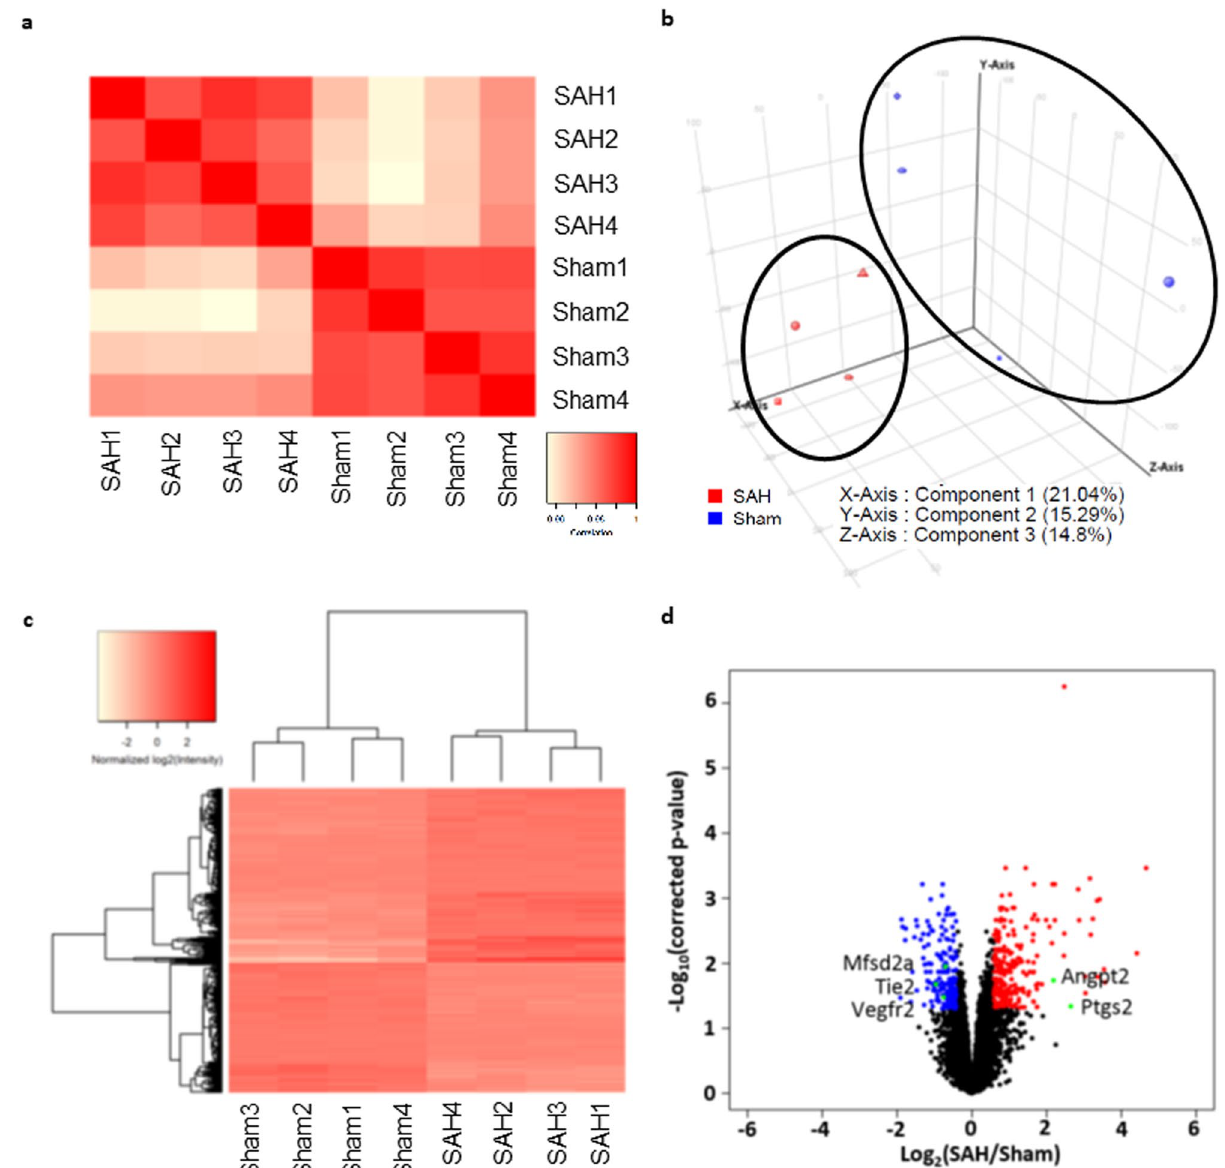
Figure 4. Gene expression profiling of CD45–CD31 + brain endothelial cells. ( a – c ) Pearson’s correlation, principal component analysis (PCA), and unsupervised hierarchical clustering revealed clustering of SAH and sham biological replicates based on gene expression profiling of CD45–CD31 + BECs. ( d ) Volcano plot demonstrating 707 genes with significant differential expression 24 h after SAH vs. sham procedure (2.8% of 24,865 interrogates probe sets). There were 403 upregulated genes and 304 downregulated genes. Red dots show the 200 genes that were significantly upregulated by more than 1.5-fold. Blue dots show the 304 genes that significantly downregulated to 75% of baseline. Specific genes of interest are labeled with green dots. n = 4 per group. Abbreviations: Angpt2 : Angiopoietin 2; Mfsd2a : Major facilitator superfamily domain containing 2a; Ptgs2 /COX-2: Prostaglandin-endoperoxide synthase 2; Tie2 : Tunica intima endothelial kinase 2; Vegfr2 : Vascular endothelial growth factor receptor